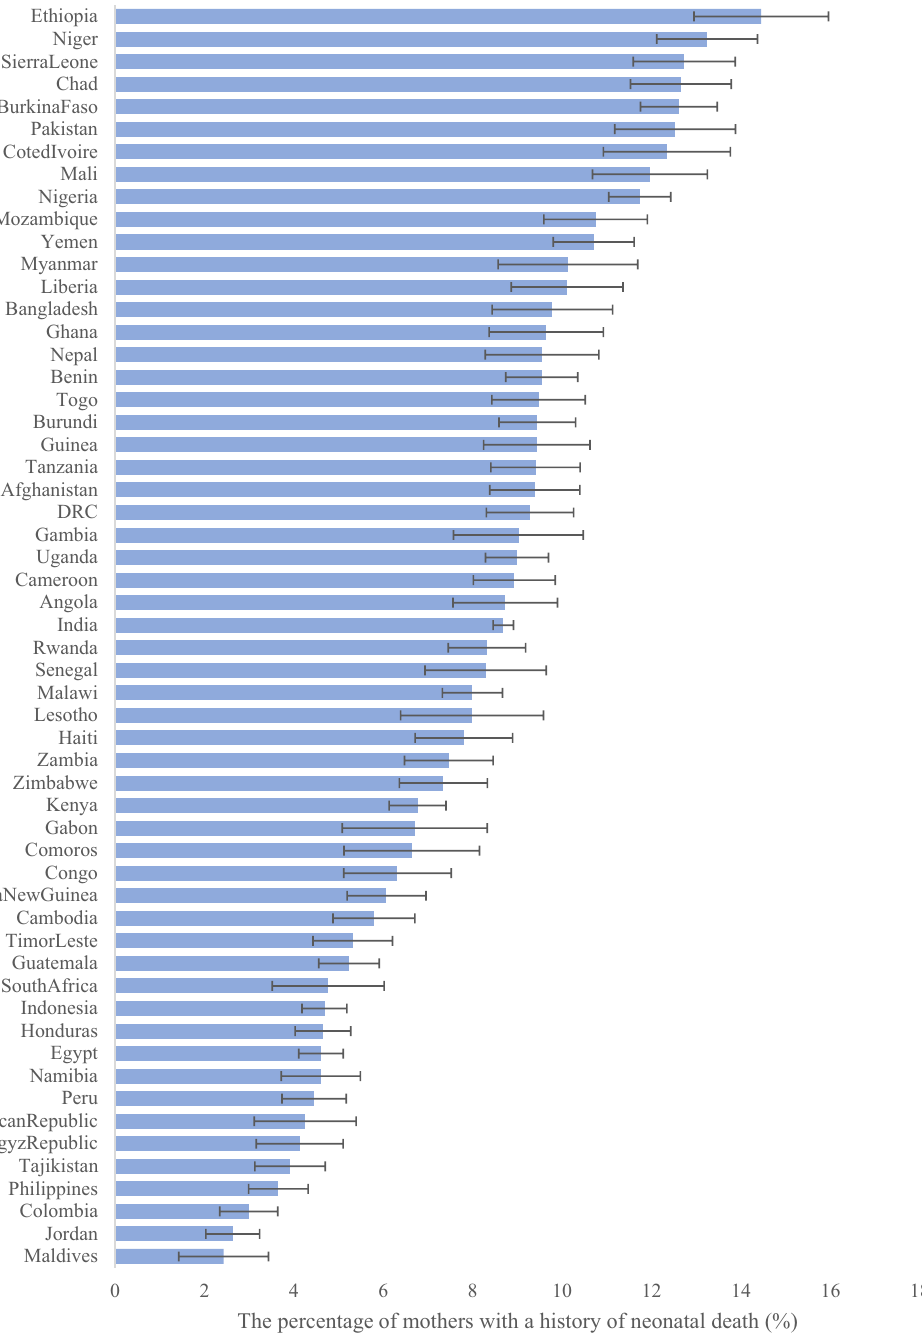
Figure 1. Between-country variations in percent of mothers with history of neonatal